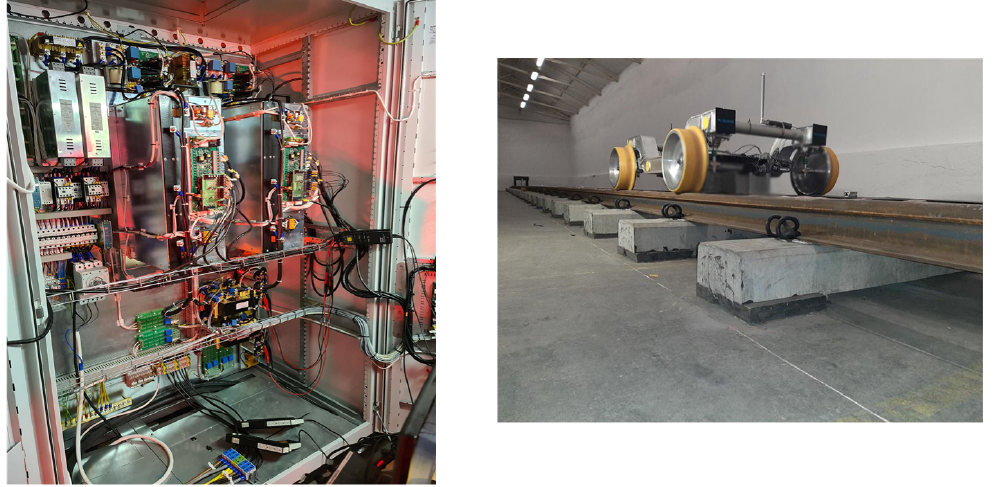
Figure 16. View of the laboratory track and the power electronic